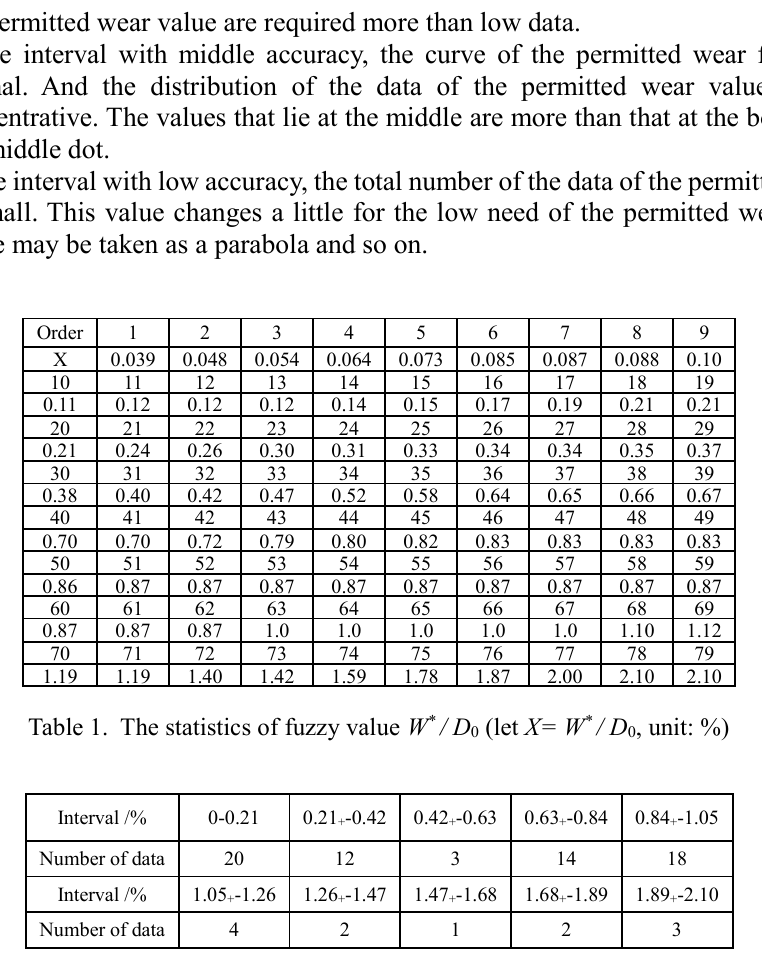
Table 2. Number of data in the sub-interval of W * / D